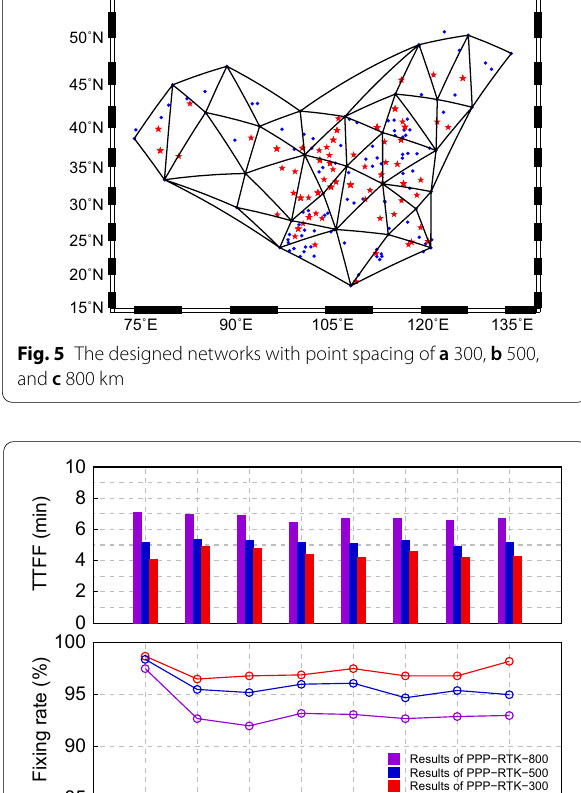
3 TECU), and d the =